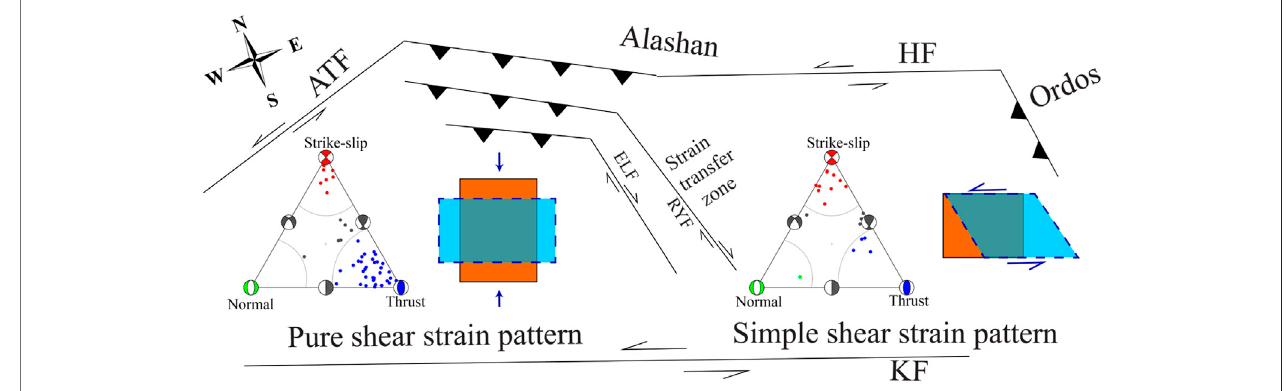
FIGURE 7 | Schematic illustrations of the model for the deformation pattern of